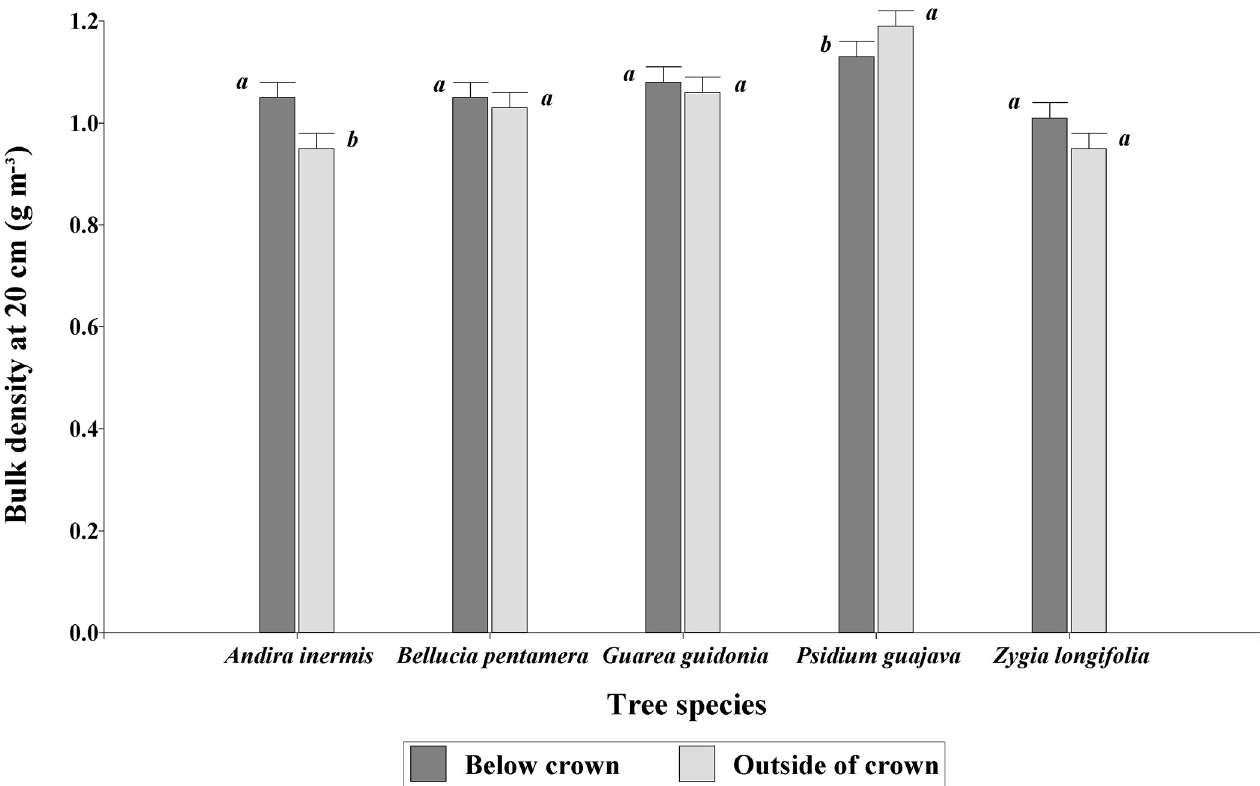
Fig 3. Soil bulk density values in the species-by-distance interaction at 20 cm depth. Equal letters within species indicate equal means (P > 0.05).